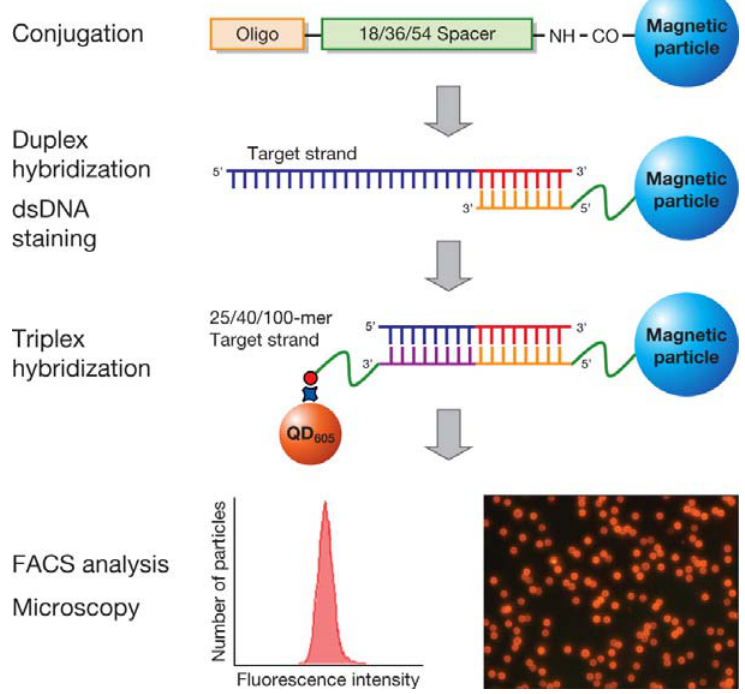
Figure 1. Schematic procedure of the MP and QD-based hybridization